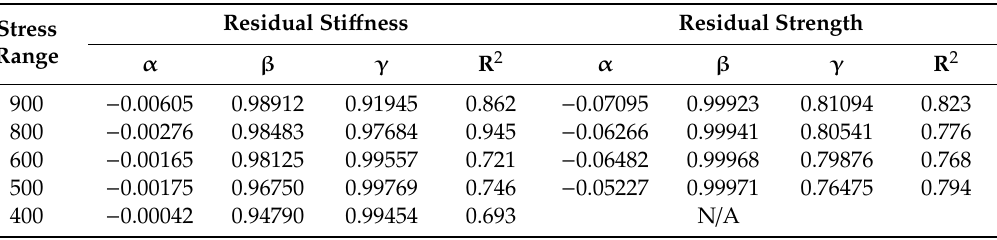
Table 2. Parameters of the proposed fatigue model.